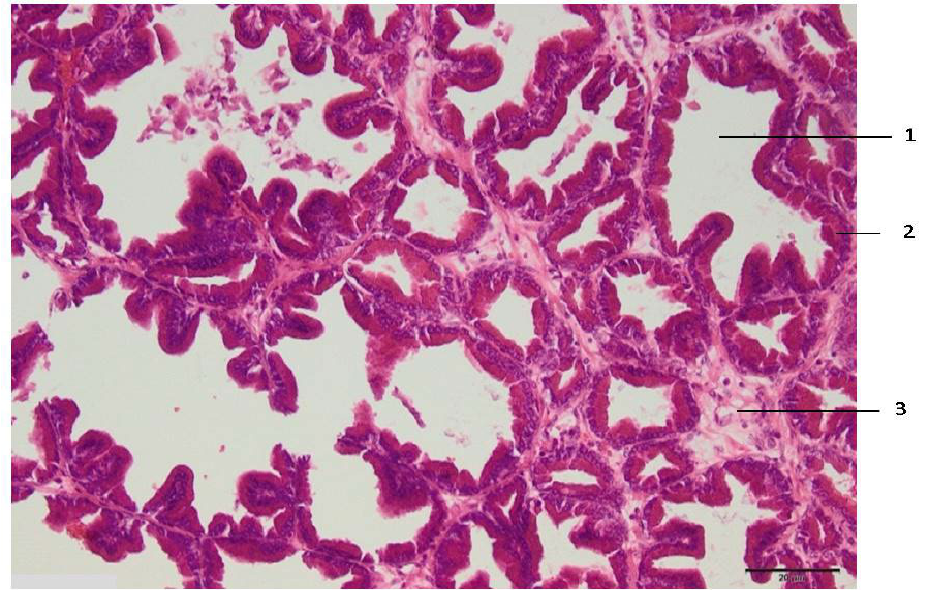
Figure 2. Histologic zone II of the prostate lesion: 1—alveolar gland of the prostate; 2—secretory epithelium with dark pycnotic nuclei; 3—connective tissue edema. Microtome-cut sections of prostate samples were stained with hematoxylin and eosin.